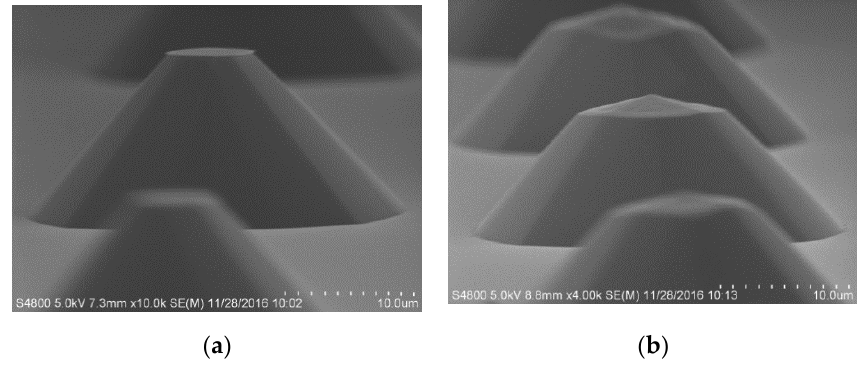
Figure 6. Two-step etching scanning electron microscope (SEM) of “ger” model: ( a ) etching is performed in 25 wt % TMAH + Triton at 70 °C for 60 min to form a circular mesa; ( b ) the “ger” model was fabricated by chamfering the top edge.